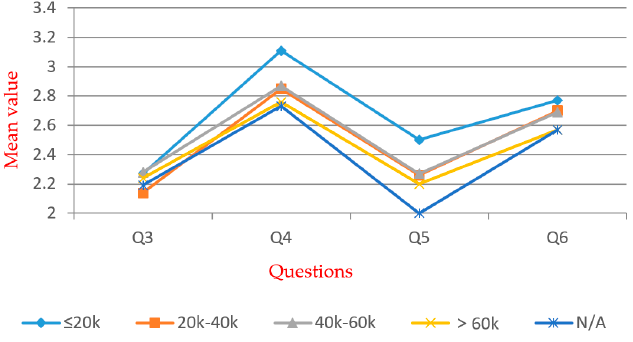
Figure 8. Mean values of “education” group.